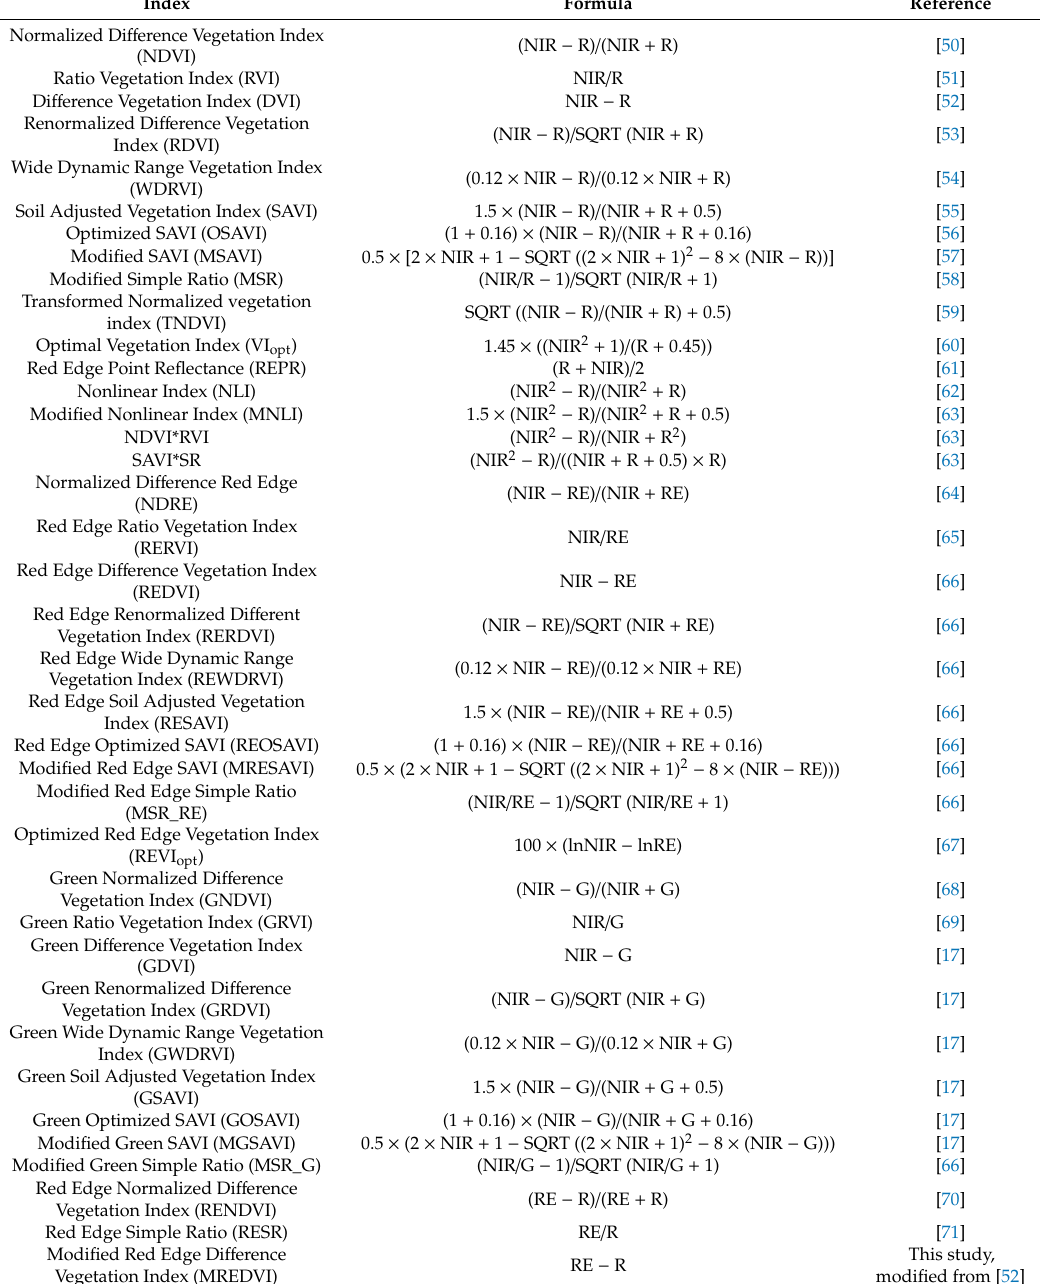
Table A1. The vegetation indices evaluated in this study. G, R, RE, and NIR indicate green, red, red edge, and near infrared band